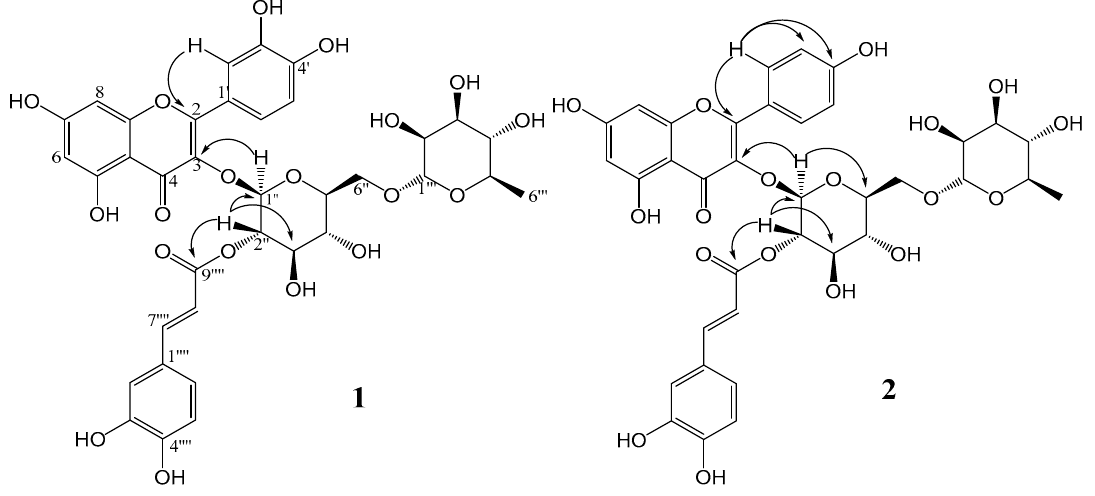
Figure 2. Key HMBC correlations of compounds 1 and 2 .